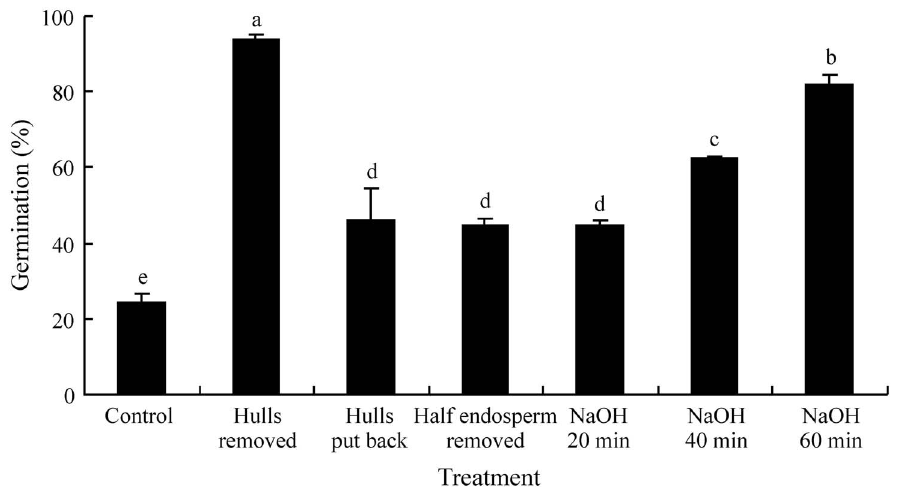
Figure 2. Effect of hulls, half-endosperm removal and NaOH scarification on germination of fresh seeds of Stipabungeana at 20 u C in dark. Different letters indicate significant difference (P , 0.05) among all treatments (n=4).